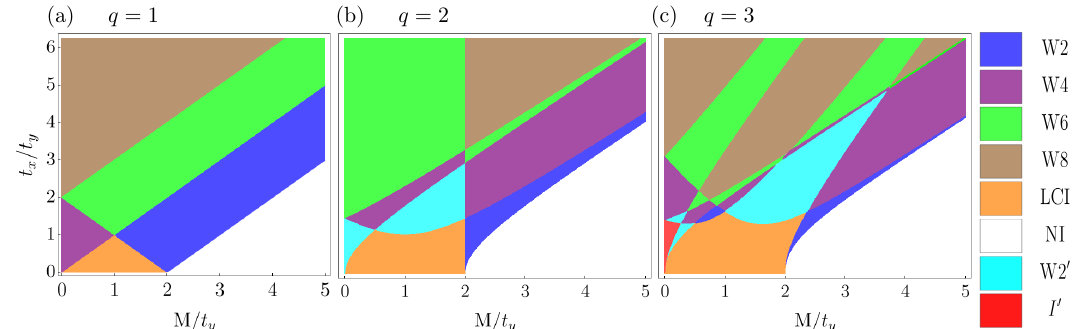
Figure 1: The phase diagram for (a) zero field ( q = 1) and (b)-(c) for finite com- = t ( 1 ) = t mensurate fields ( q = 2,3), with t ( 1 ) . (a) The gapless phases consisting y z y of WSM phases with 1, 2, 3, and 4 pairs of Weyl nodes are shown in blue, purple, green, and brown. The gapped phase (in orange) is a layered Chern insulator (LCI), where the 2D Chern layers are coupled via t . The white region at the right bottom x corner represents a trivial insulator. In (b)-(c) the WSM phases have 2 q , 4 q , 6 q , and 8 q Weyl nodes in the bulk, labeled W2, W4, W6, and W8 respectively. In non-zero magnetic fields, two additional phases appear which are labeled W2 (cid:48) and I (cid:48) . The W2 (cid:48) phase (aqua) is gapless and has 2 q Weyl nodes, but coexists with an LCI, and hence possesses gapless surface modes in addition to the usual Fermi arcs. The I (cid:48) phase is a gapped, topologically trivial, insulating phase but has counterpropagating zero-energy surface states. We also note that the gapped LCI and I (cid:48) phases take up regions from the WSM phases and expand with increasing q . We emphasize that the phases of the same color in (a), (b), and (c) are not identical. The number of Weyl nodes in corresponding phases is related by the factor q